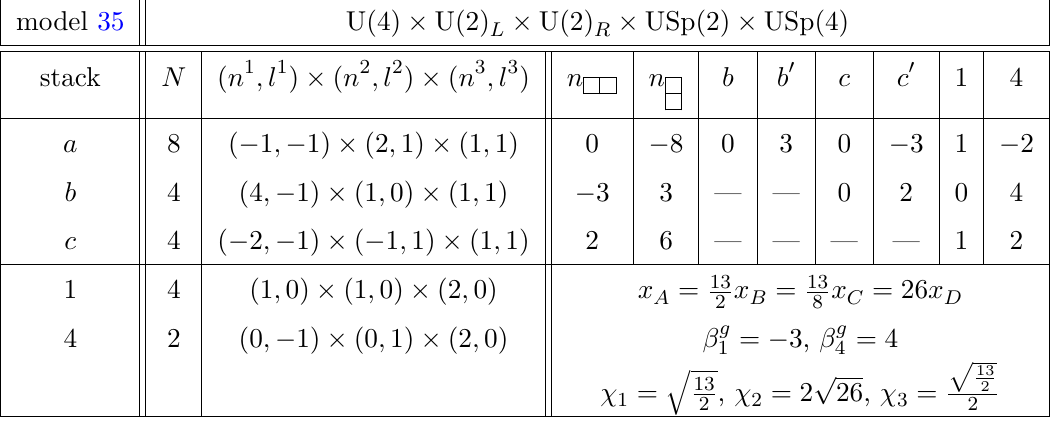
Table 35 . D6-brane configurations and intersection numbers of Model 35, and its MSSM